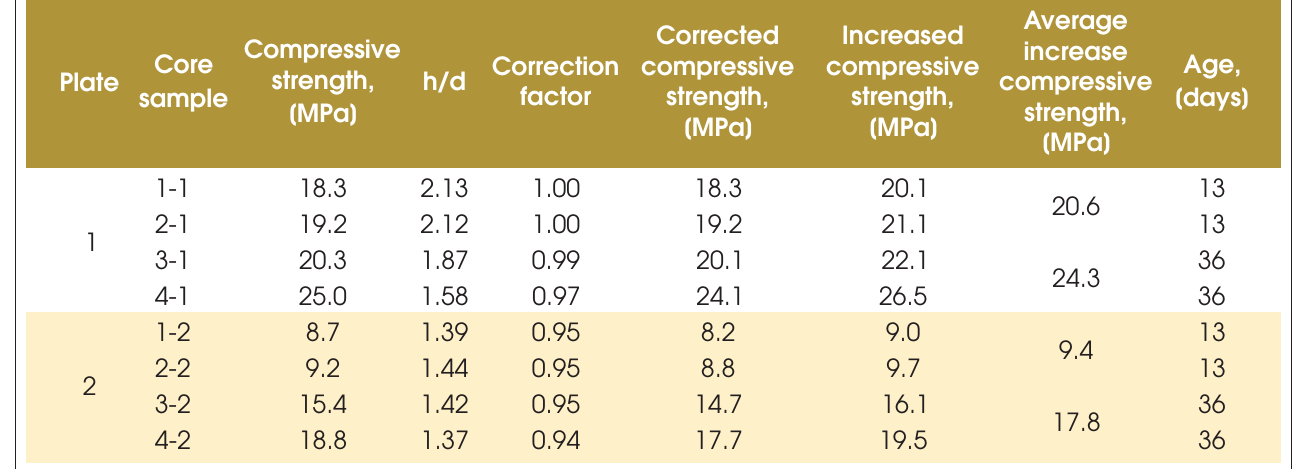
Table 4 – Results of the compressive strength testing of samples extracted from the concrete plates